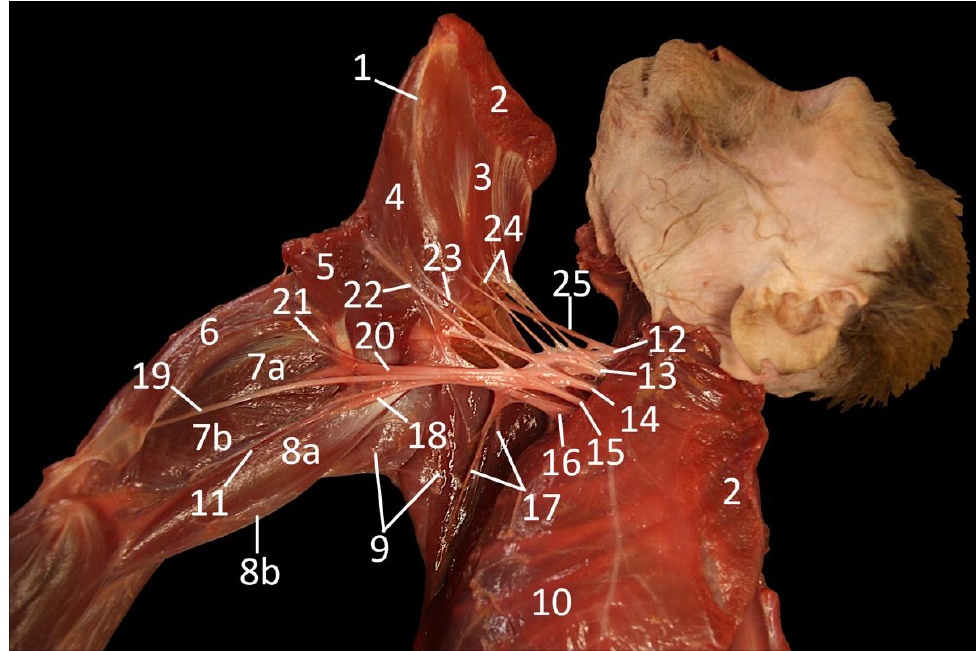
Figure 4. Dorsolateral view of the axillary region with emphasis on the plexus brachialis after partial amputation of the left forelimb that is rotated cranially. As such, a caudomedial view of the forelimb and a lateral view of the left thoracic wall are obtained.